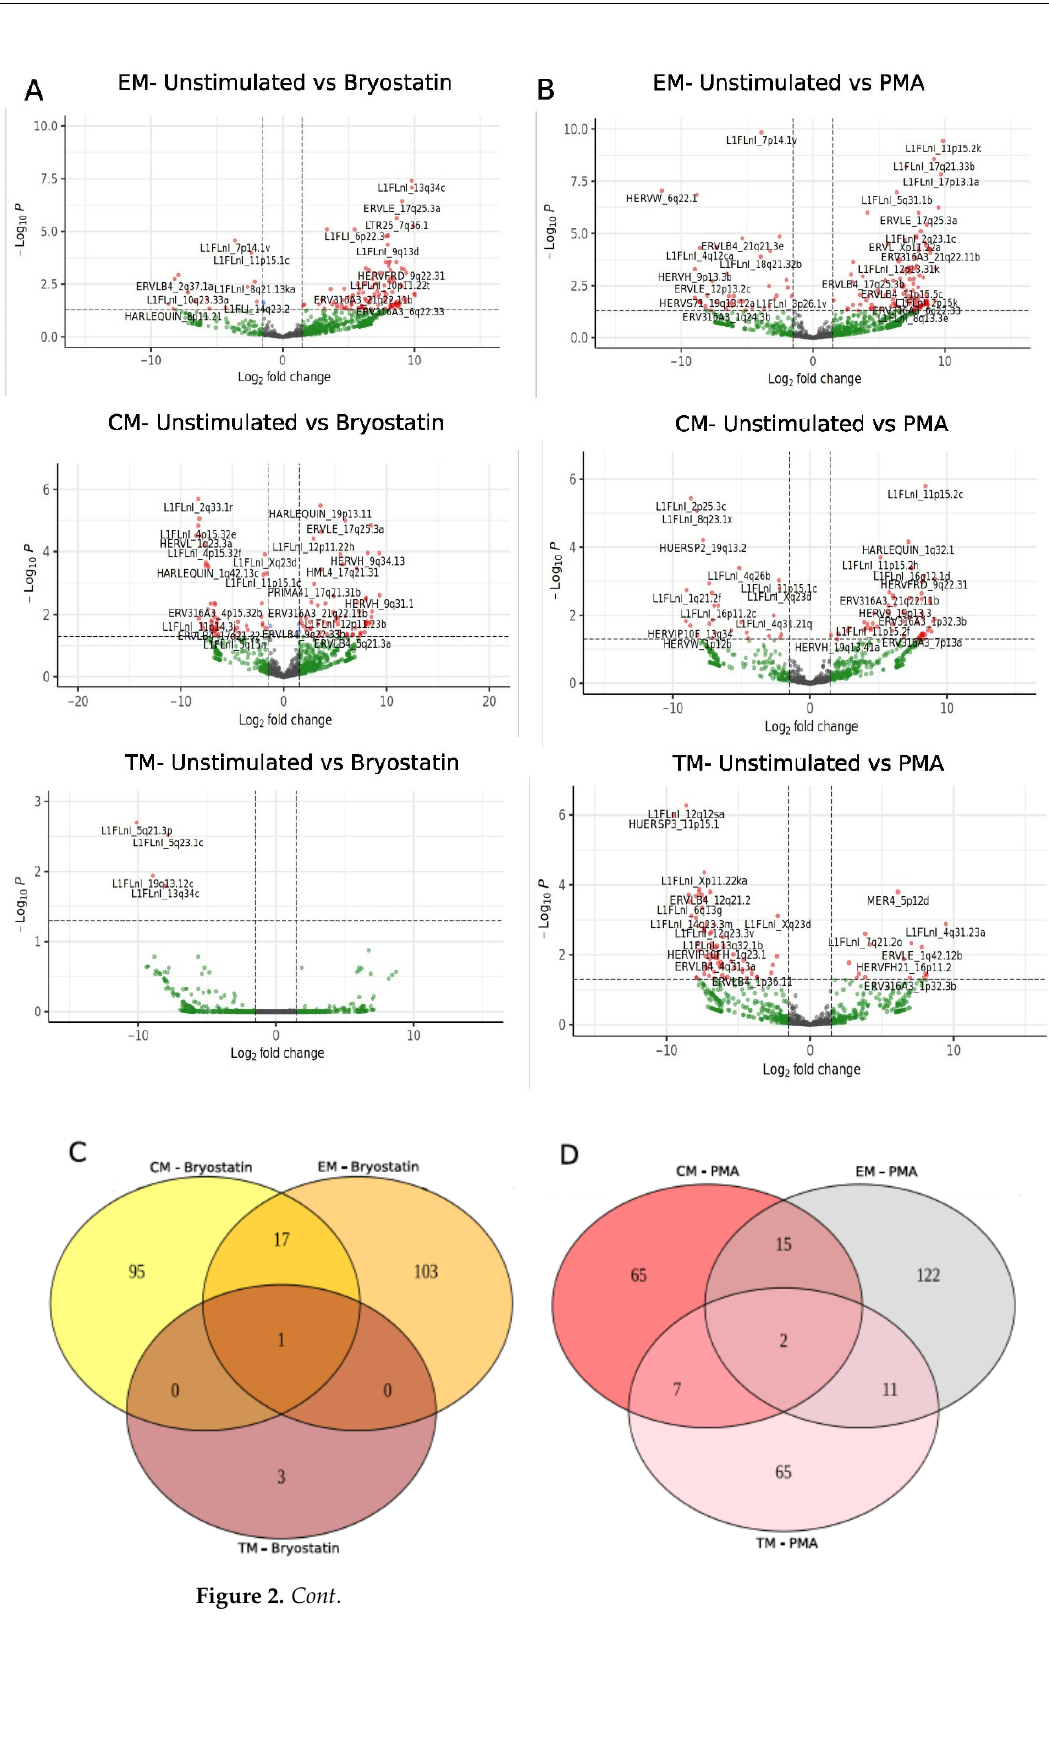
Figure 2. Differential expression of transposable elements in CD4+ T cells treated with Bryostatin and PMA. Volcano plots for each memory CD4+ T-cell subset are shown for Bryostatin ( A ) and PMA treatment ( B ). Venn plots depict commonly and exclusively regulated TEs for Bryostatin ( C ) and